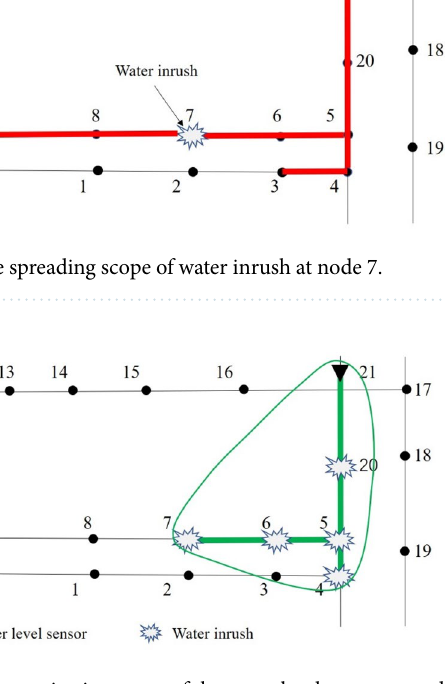
Figure 3. The monitoring scope of the water level sensor at node